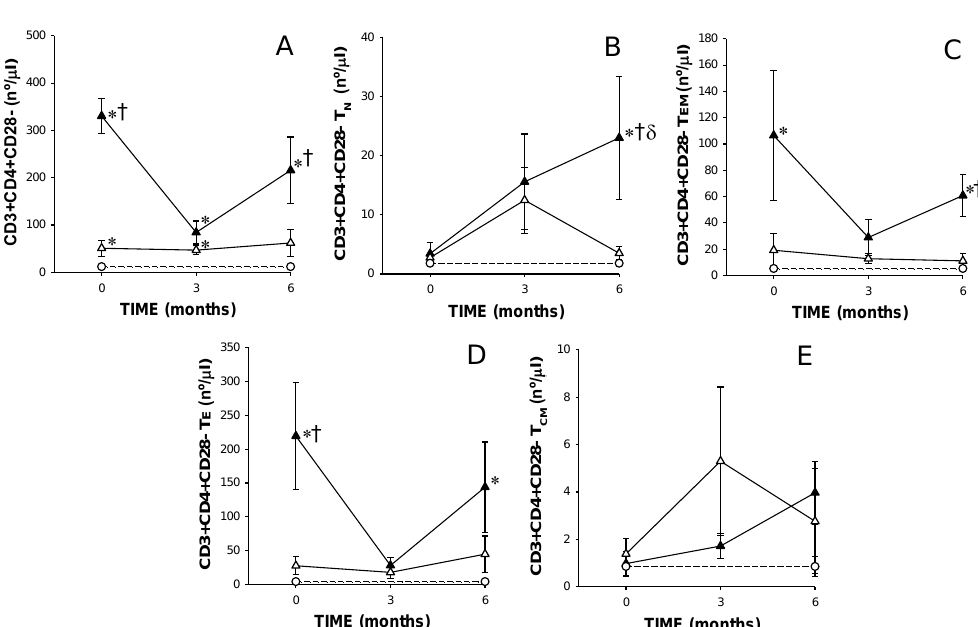
Figure 4. Panels A–E represents counts of CD4 + CD28 − T lymphocytes subsets in eventual responders Figure 2. Panels A – E represents total and activation/differentiation stage subsets of CD4+ T Figure 4. Panels A – E represents counts of CD4+CD28 − T lymphocytes subsets in eventual Figure 2. Panels A – E represents total and activation/differentiation stage subsets of CD4+ T Figure 2. Panels A – E represents total and activation/differentiation stage subsets of CD4+ T and non-responders at baseline, and between responders and non-responders after 3 and 6 months lymphocytes in eventual responders and non-responders at baseline, and between responders and responders and non-responders at baseline, and between responders and non-responders after 3 and lymphocytes in eventual responders and non-responders at baseline, and between responders and lymphocytes in eventual responders and non-responders at baseline, and between responders and of treatment. Note. Values represent numbers of total CD4 + CD28 − T lymphocytes and in their 6 months of treatment. Note. Values represent numbers of total CD4+CD28 − T lymphocytes and in non-responders after 3 and 6 months of treatment. Note . Values represent numbers of naïve ( T N ), non-responders after 3 and 6 months of treatment. Note . Values represent numbers of naïve ( T N ), non-responders after 3 and 6 months of treatment. Note . Values represent numbers of naïve ( T N ), their activation/differentiation stages (T N , T EM , T E and T CM ) from ( ) responders (including eventual effector memory (T EM ), effector (T E ) and central memory (T CM ) CD4 + T cells from ( )responders activation / di ff erentiation stages (T N , T EM , T E and T CM ) from ( effector memory (T EM ), effector (T E ) and central memory (T CM ) CD4 + T cells from ( )responders effector memory (T EM ), effector (T E ) and central memory (T CM ) CD4 + T cells from ( )responders at baseline) and ( ) non-responders (including eventual at baseline) at up to 6 months of MTX (including eventual at baseline) and ( )non-responders (including eventual at baseline) at up to 6 (including eventual at baseline) and ( )non-responders (including eventual at baseline) at up to 6 (including eventual at baseline) and ( )non-responders (including eventual at baseline) at up to 6 ) non-responders (including eventual at baseline) at up to 6 months of MTX treatment. treatment. The dotted line represents the mean of the results obtained for each variable in this group months of MTX treatment. The dotted line represents the mean of the results obtained for each months of MTX treatment. The dotted line represents the mean of the results obtained for each months of MTX treatment. The dotted line represents the mean of the results obtained for each The dotted line represents the mean of the results obtained for each variable in this group of subjects of subjects in the three different studies performed ( ). All values are expressed as mean cell counts variable in this group of subjects in the three different studies performed ( ). All values are variable in this group of subjects in the three different studies performed ( ). All values are variable in this group of subjects in the three different studies performed ( ). All values are in the three di ff erent studies performed ( ). All values are expressed as mean cell counts ± S.E.M. ± S.E.M. *, p < 0.05 for responders or non- responders (including eventual) vs. healthy controls; †, p < expressed as mean cell counts ± S.E.M. *, p < 0.05 for responders or non-responders (including expressed as mean cell counts ± S.E.M. *, p < 0.05 for responders or non-responders (including expressed as mean cell counts ± S.E.M. *, p < 0.05 for responders or non-responders (including 0.05 for responders vs. non-responders (including eventual), σ p < 0.05 for values at 3 months of *, p < 0.05 for responders or non-responders (including eventual) vs. healthy controls; † , p < 0.05 for eventual) vs. healthy controls; †, p < 0.05 for responders vs. non-responders (including eventual), σ , p eventual) vs. healthy controls; †, p < 0.05 for responders vs. non-responders (including eventual), σ , p treatment compared to baseline, ‡, p < 0.05 at 6 months of treatment time compared to 3 months, and responders vs. non-responders (including eventual), σ p < 0.05 for values at 3 months of treatment eventual) vs. healthy controls; †, p < 0.05 for responders vs. non-responders (including eventual), σ , p < 0.05 for values at 3 months of treatment compared to baseline, ‡, p < 0.05 at 6 months of treatment δ , p < 0.05 at 6 months of treatment time compared to baseline. < 0.05 for values at 3 months of treatment compared to baseline, ‡, p < 0.05 at 6 months of treatment compared to baseline, ‡ , p < 0.05 at 6 months of treatment time compared to 3 months, and δ , p < 0.05 < 0.05 for values at 3 months of treatment compared to baseline, ‡, p < 0.05 at 6 months of treatment time compared to 3 months, and δ , p < 0.05 at 6 months of treatment time compared to baseline. time compared to 3 months, and δ , p < 0.05 at 6 months of treatment time compared to baseline. at 6 months of treatment time compared to baseline. Cells 2019 , 8 , x FOR PEER REVIEW time compared to 3 months, and δ , p < 0.05 at 6 months of treatment time compared to baseline.